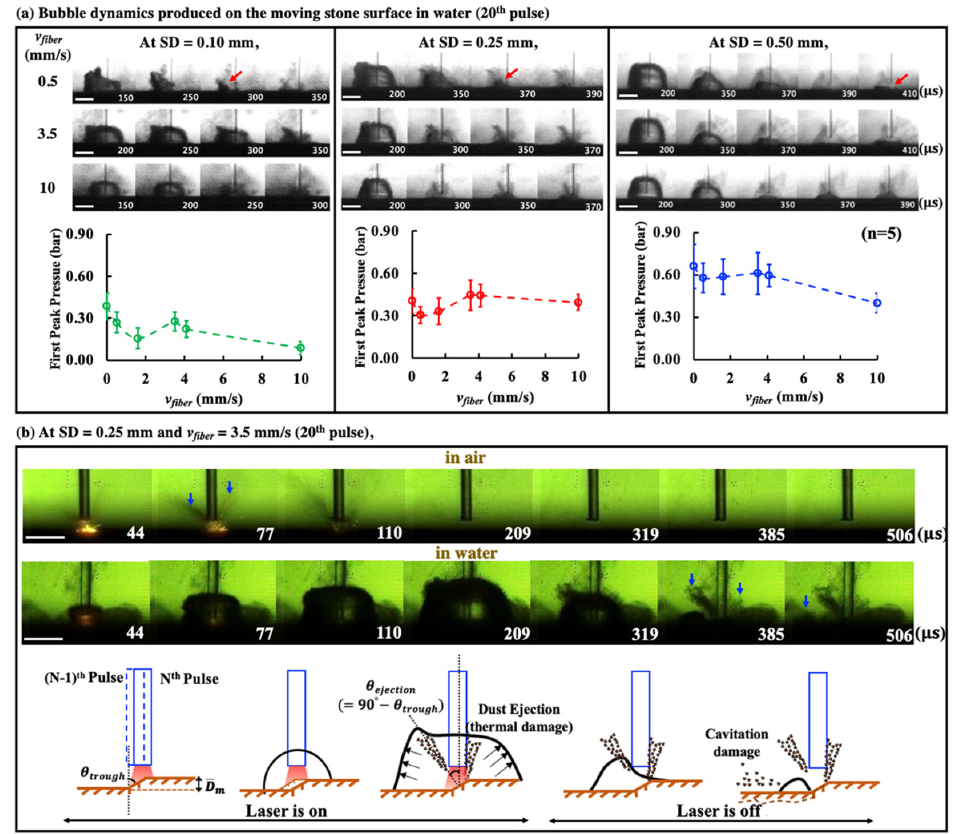
Figure 5. ( a ) High-speed imaging sequences in which the bubble produced on the stone surface moving at different speeds ( v fiber ) expands to its maximum volume and collapses at different SDs (scale bar = 1 mm). The red arrows indicate the direction of bubble collapse. The first peak pressure obtained from the hydrophone measurements is plotted vs. v fiber . The direction of stone movement in the high- speed imaging was from right to left. ( b ) Representative high-speed imaging sequences of laser-stone interaction in air vs. in water at one of the optimal settings (SD = 0.25 mm, v fiber = 3.5 mm/s) (scale bar = 1 mm) and the sketch of general process of stone dusting produced in water, where θ trough is the angle of trough damage produced by the first N pulse, and θ ejection is the angle of material ejection from stone surface. The blue arrows indicate the material